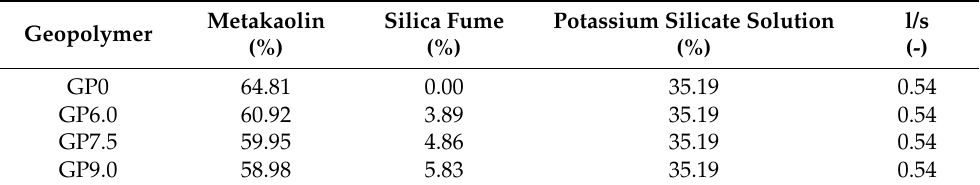
Table 2. Mass fraction of metakaolin, silica fume and potassium silicate solution and l/s-ratio of the